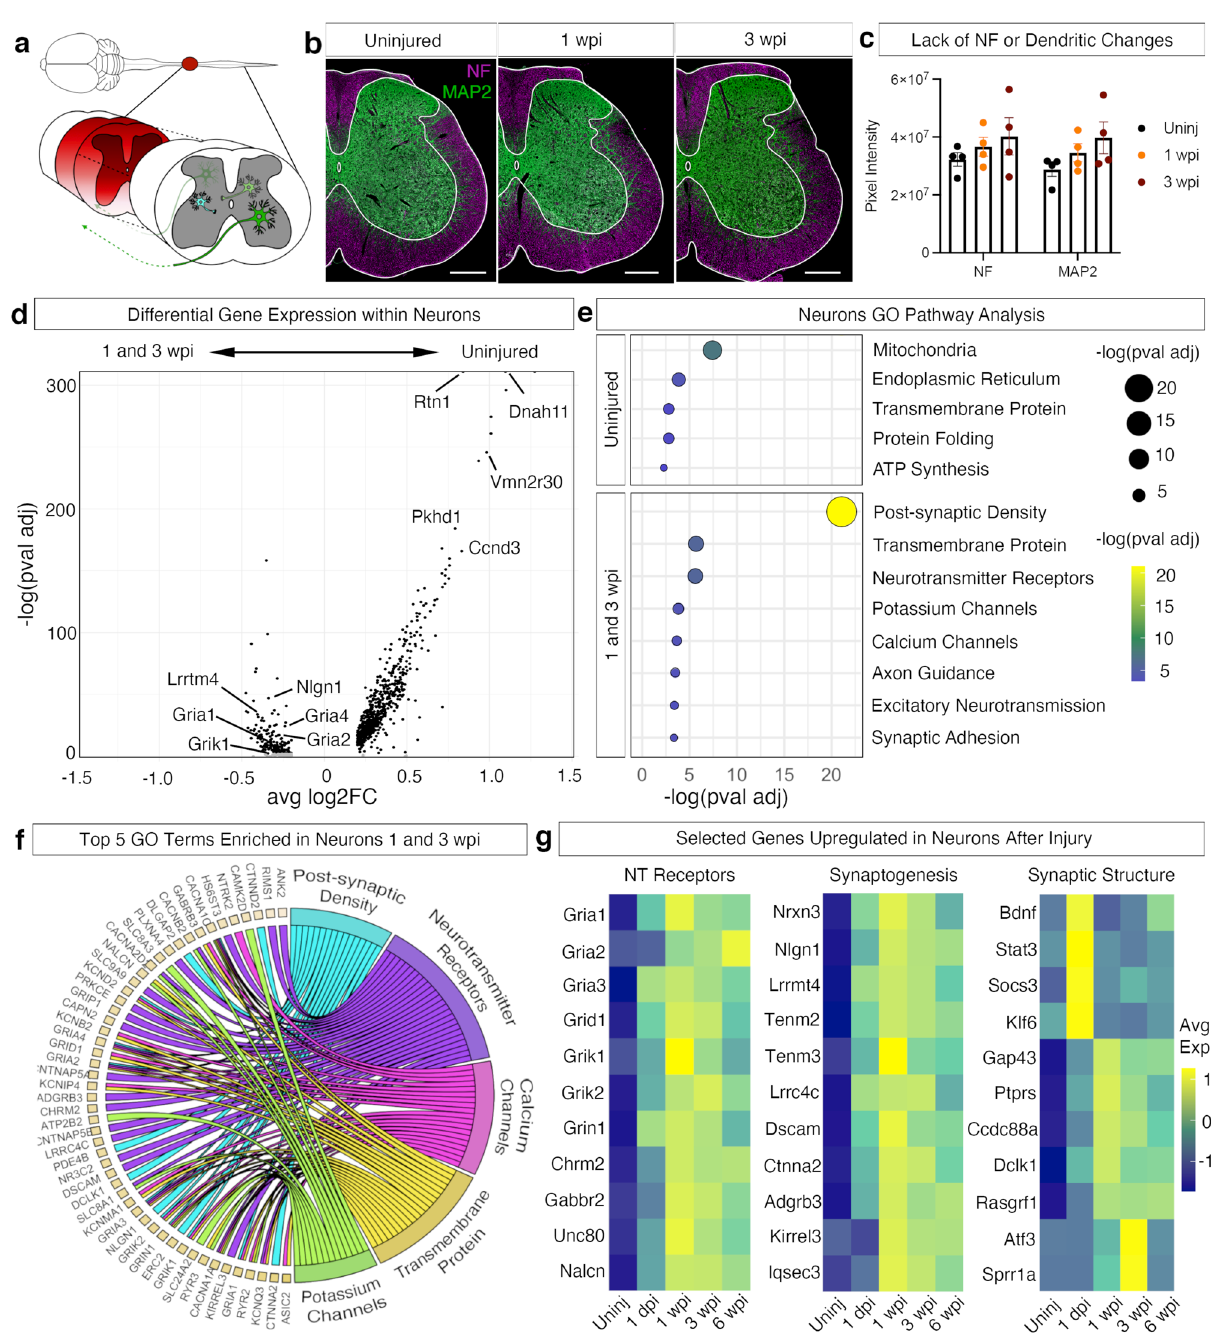
Fig. 3 | Plasticity-related expression in neurons after injury. a Schematic depictinglumbarspinalcordneuronsandtheirresponsetoinjury,whetherthatbean ascending neuron or an interneuron. b Immunohistochemistry of the lumbar spinal cordfromuninjured,1wpiand3wpi.Tissuewasstainedforneuro fi lament(acocktail of neuro fi lament-light, neuro fi lament-medium, neuro fi lament-heavy; purple) and MAP2(green).Scalebarsare200 µ m. c Quanti fi cationofneuro fi lamentand dendritic changes.Pixelswerequanti fi edfromthresholdedimagesofneuro fi lamentandMAP2. Error bars are mean±SEM ( N =4). d Differential gene expression analysis comparing uninjured to 1 and 3 wpi neurons, the time points of maximal neuronal gene expression changes. Black dots indicate p value adjusted < 0.001, gray indicate